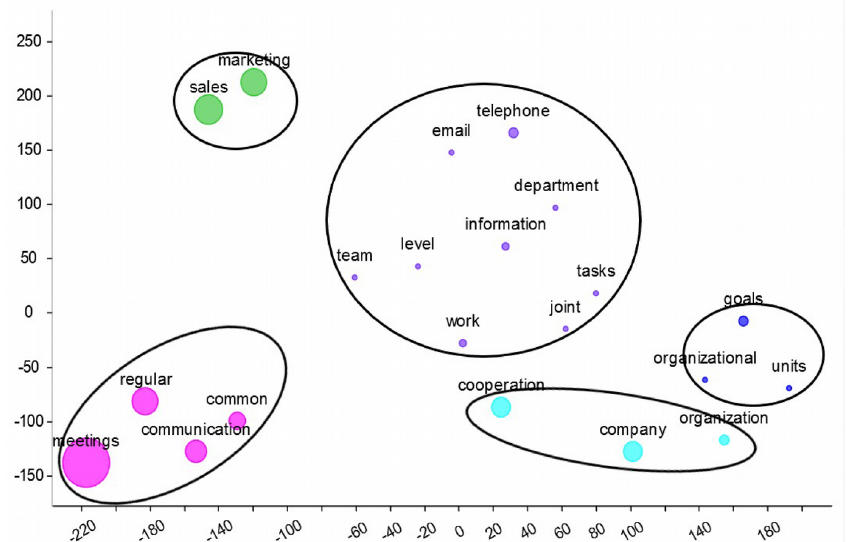
Figure 7. t-SNE generated clusters for the answers to Question 3 at perplexity level 50 (Own editing using www.voyant.tools.org )